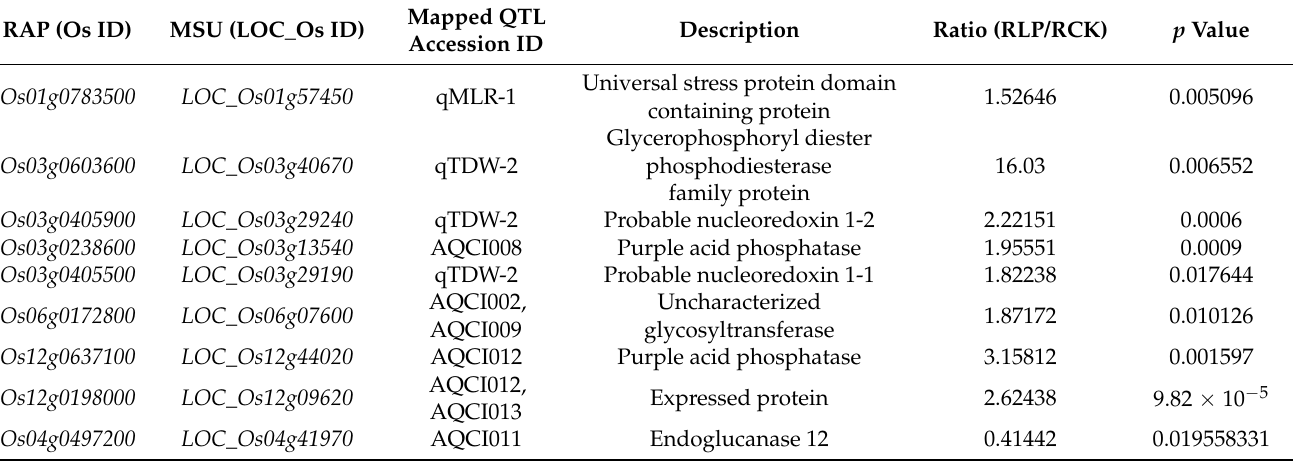
Table 5. Located genes encoded significantly different expression proteins identified from label-free quantitative analysis among previously identified P-deficiency responses related QTL